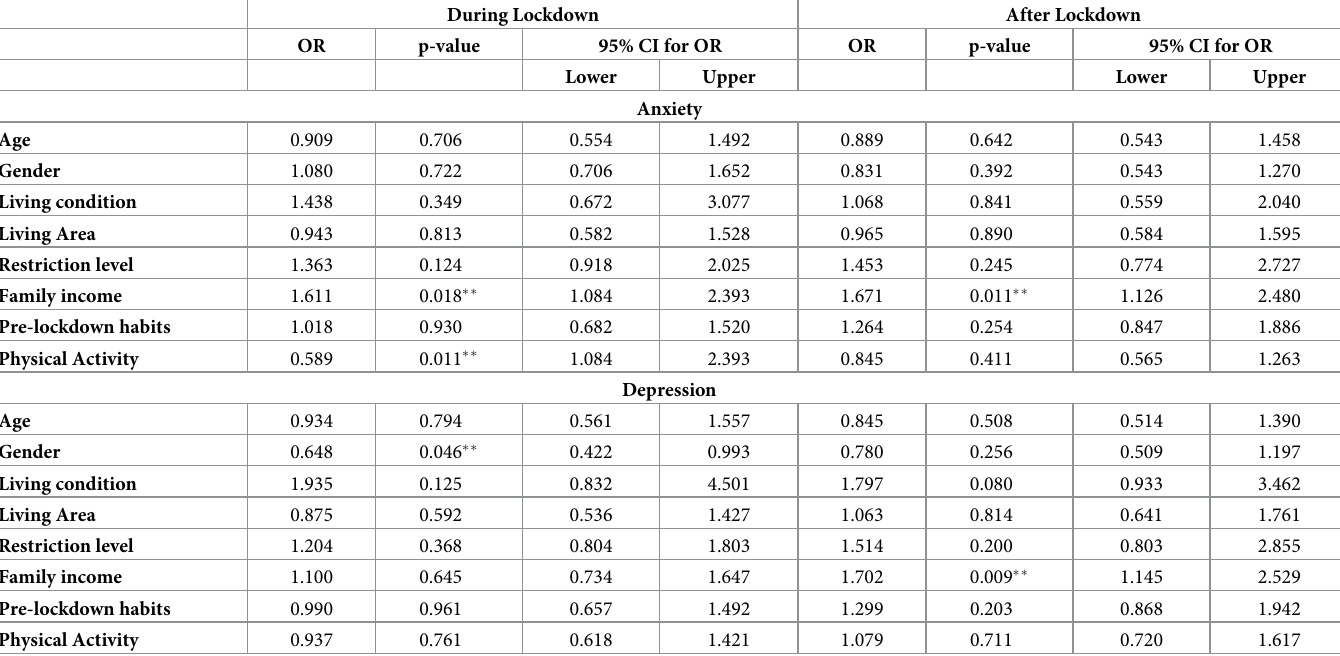
Table 4. The predictors of anxiety and depression during and after the